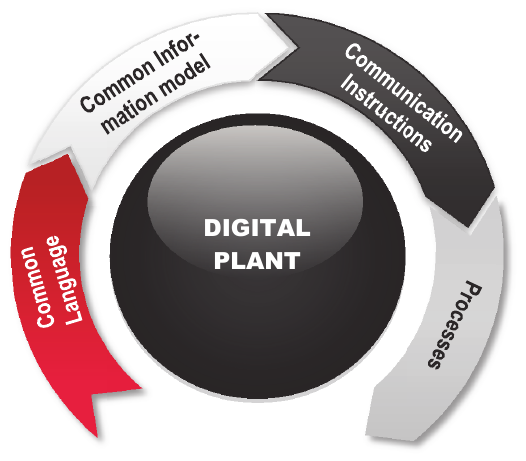
Fig. 1. Digital Plant